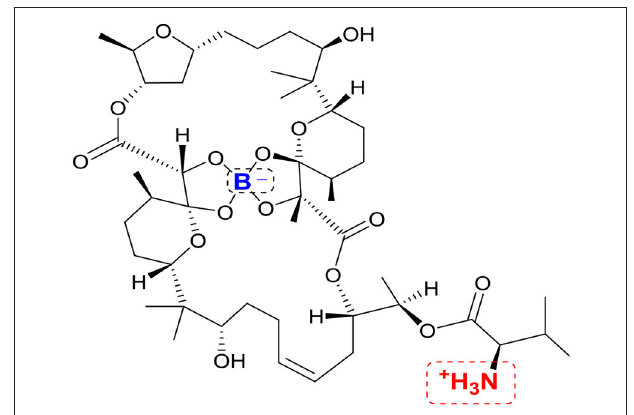
FIGURE 4 | Structure of boromycin. Positively charged amino group and negatively charged boron atom are highlighted in red and blue